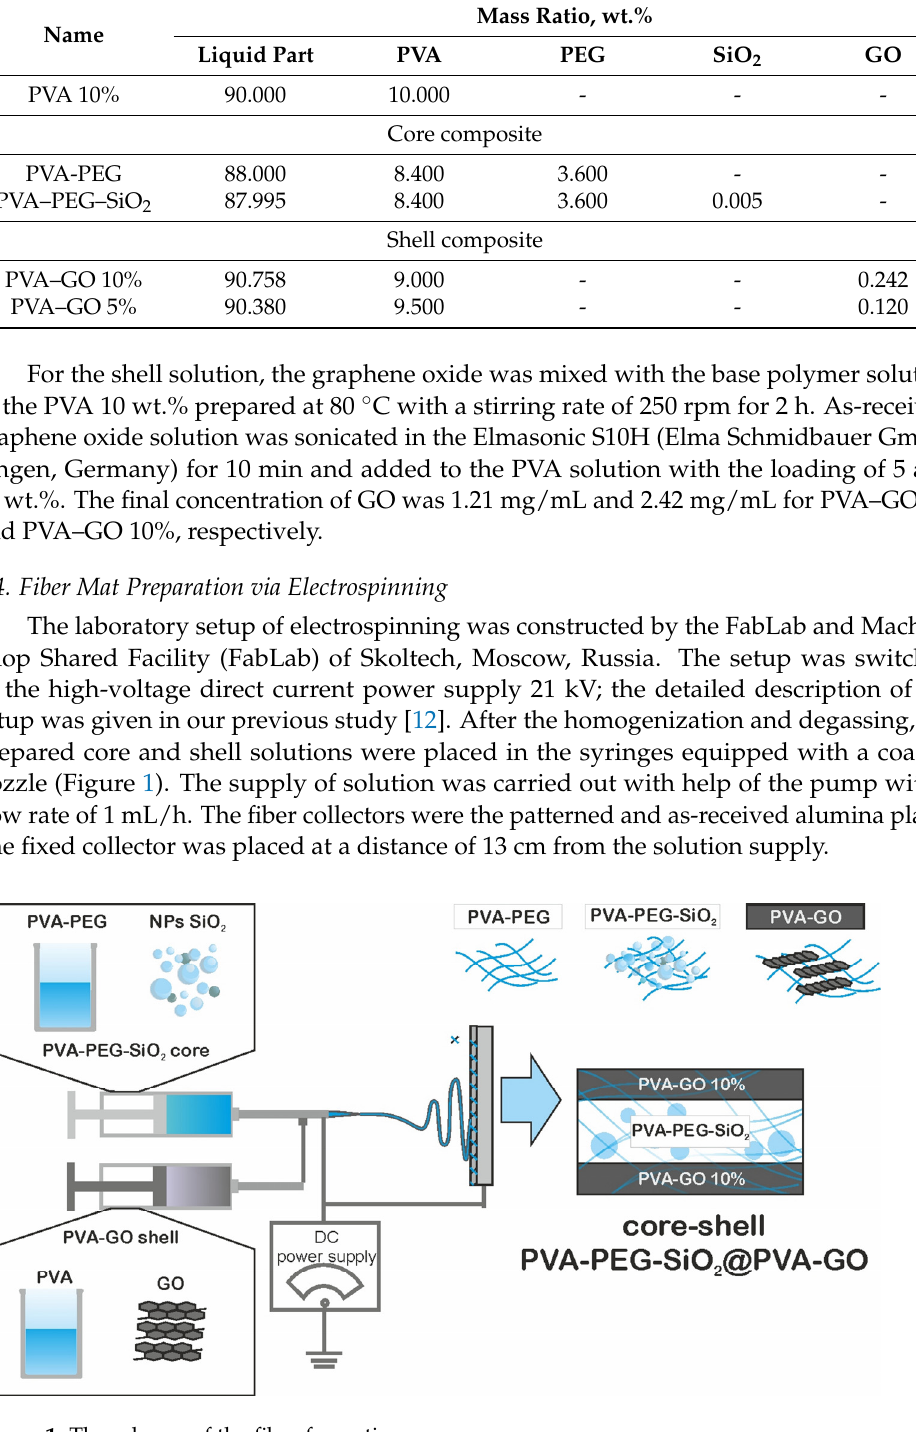
Figure 1. The scheme of the fiber formation.